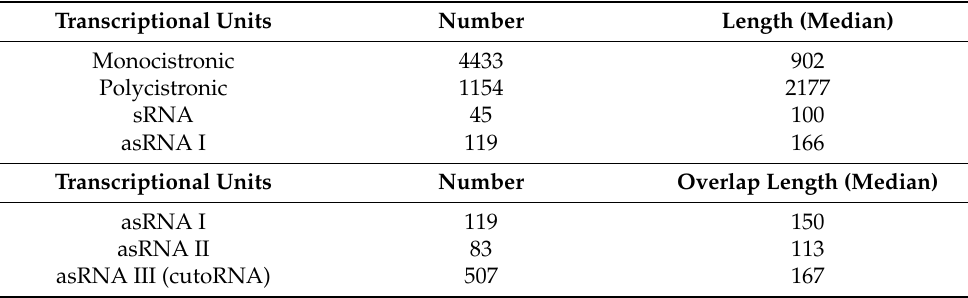
Table 1. Transcriptional unit classification in S. ambofaciens